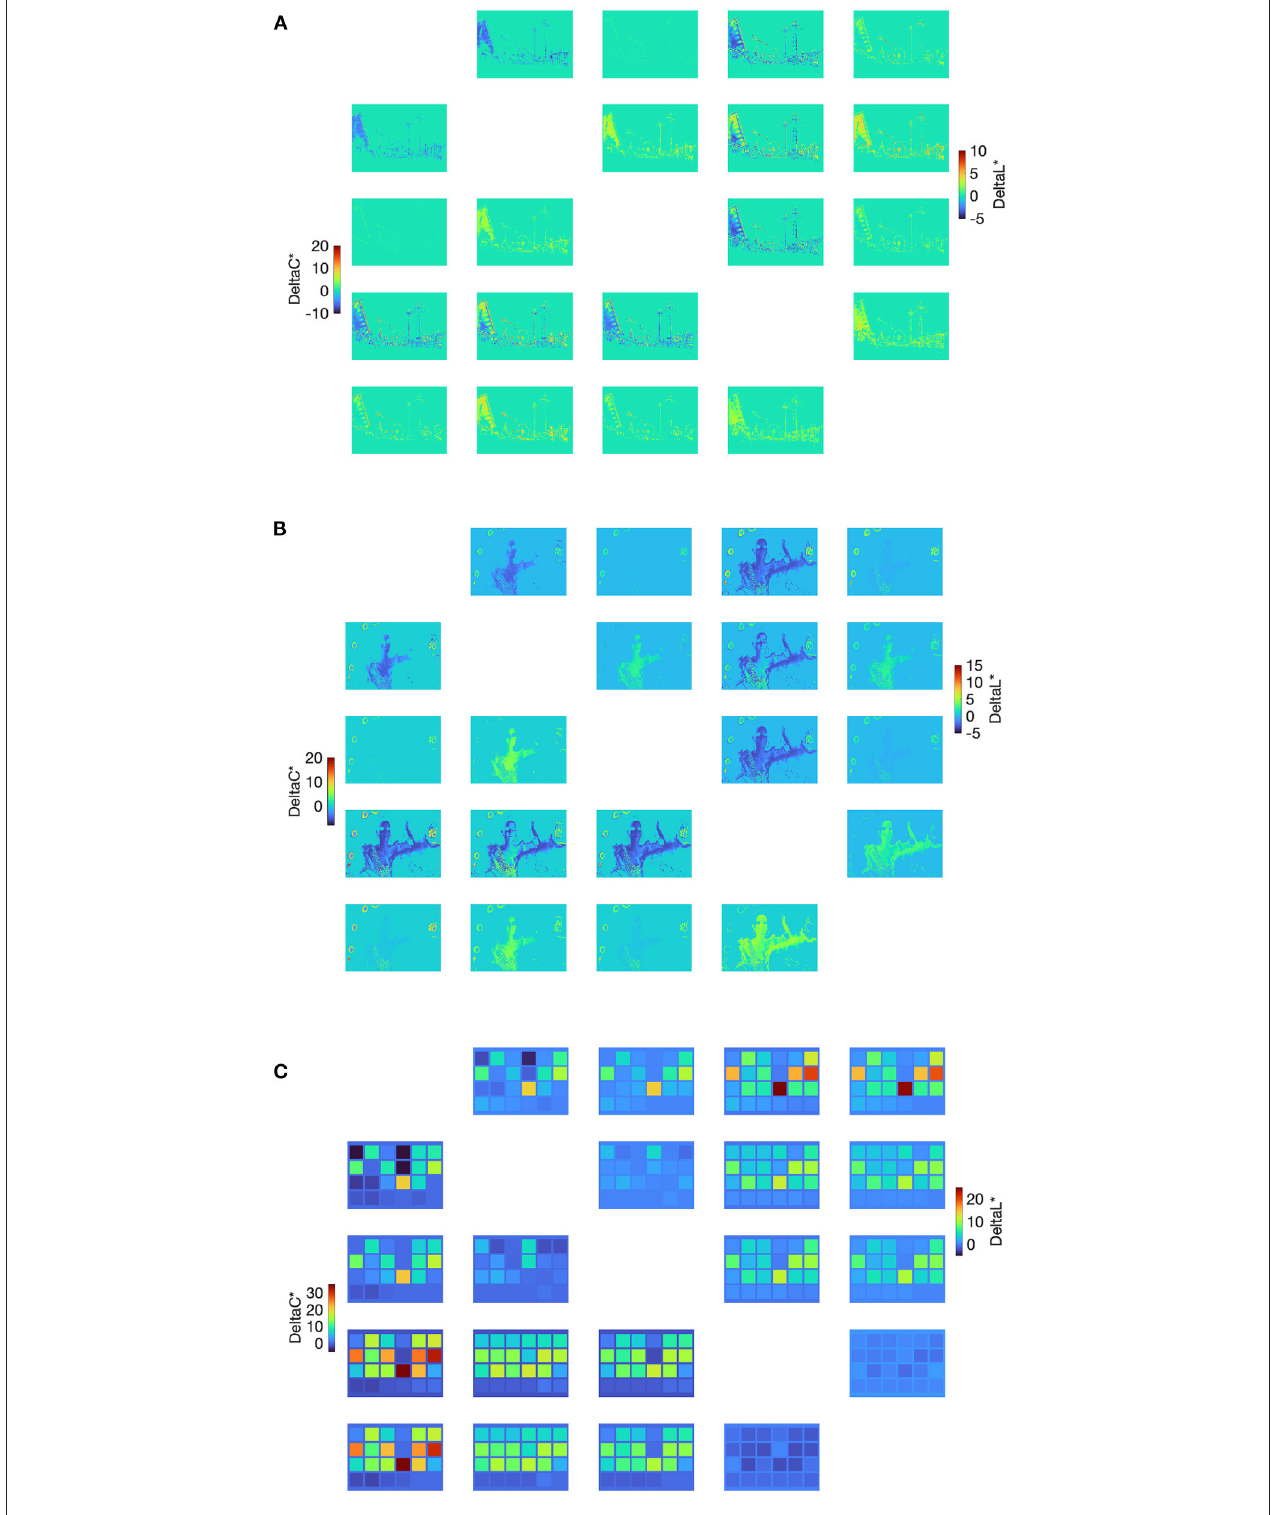
FIGURE 6 | Image color differences for both CIELAB lightness and chroma between different pairs of gamuts for image #2 (A) , image #6 (B) , and image #7 (C) . The 5 × 5 image matrix (the diagonal skipped) include both lightness difference (the upper-right triangle) and chroma difference (the lower-left triangle) that are diagonally